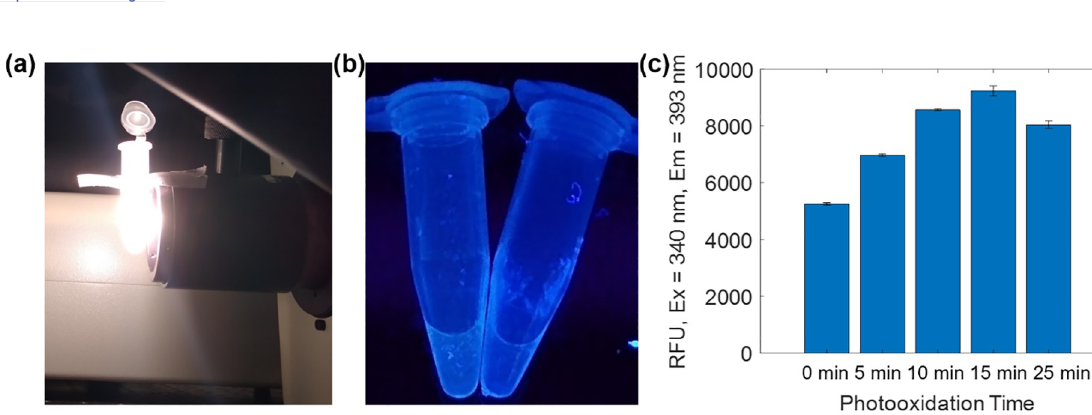
PLOS ONE | https://doi.org/10.1371/journal.pone.0237473 August 19, 2020 10 /